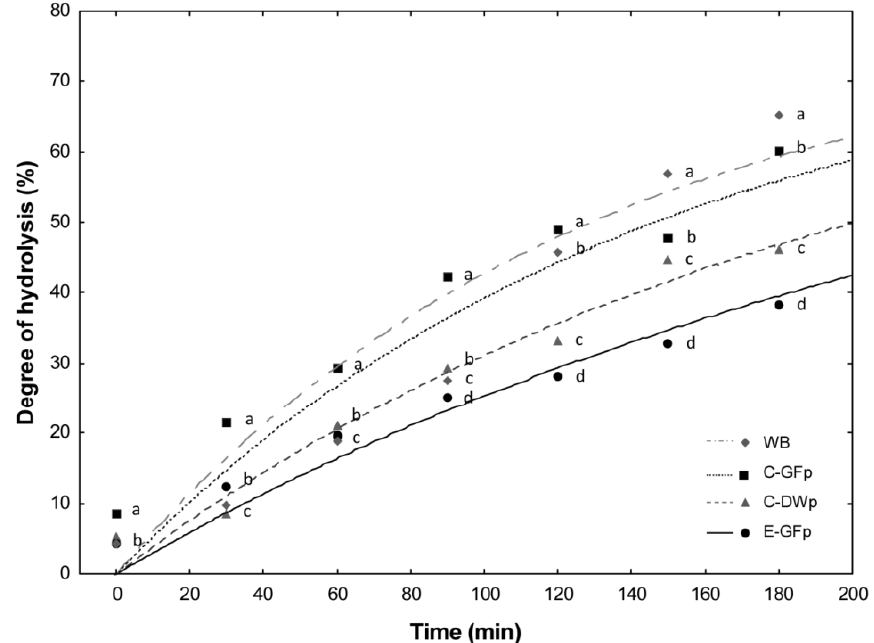
Figure 2. Rate of starch hydrolysis of pasta following chewing, incubation with pepsin, and further incubation with pancreatic α-amilase in dialysis tubing. E-GFp: experimental gluten-free pasta; C-GFp: commercial gluten-free pasta; C-DWp: commercial durum wheat pasta; WB: white wheat bread (reference). a–d Values obtained at the same time with different superscript letters differ significantly ( p < 0.05 ). Adapted from Curiel et al. [93].